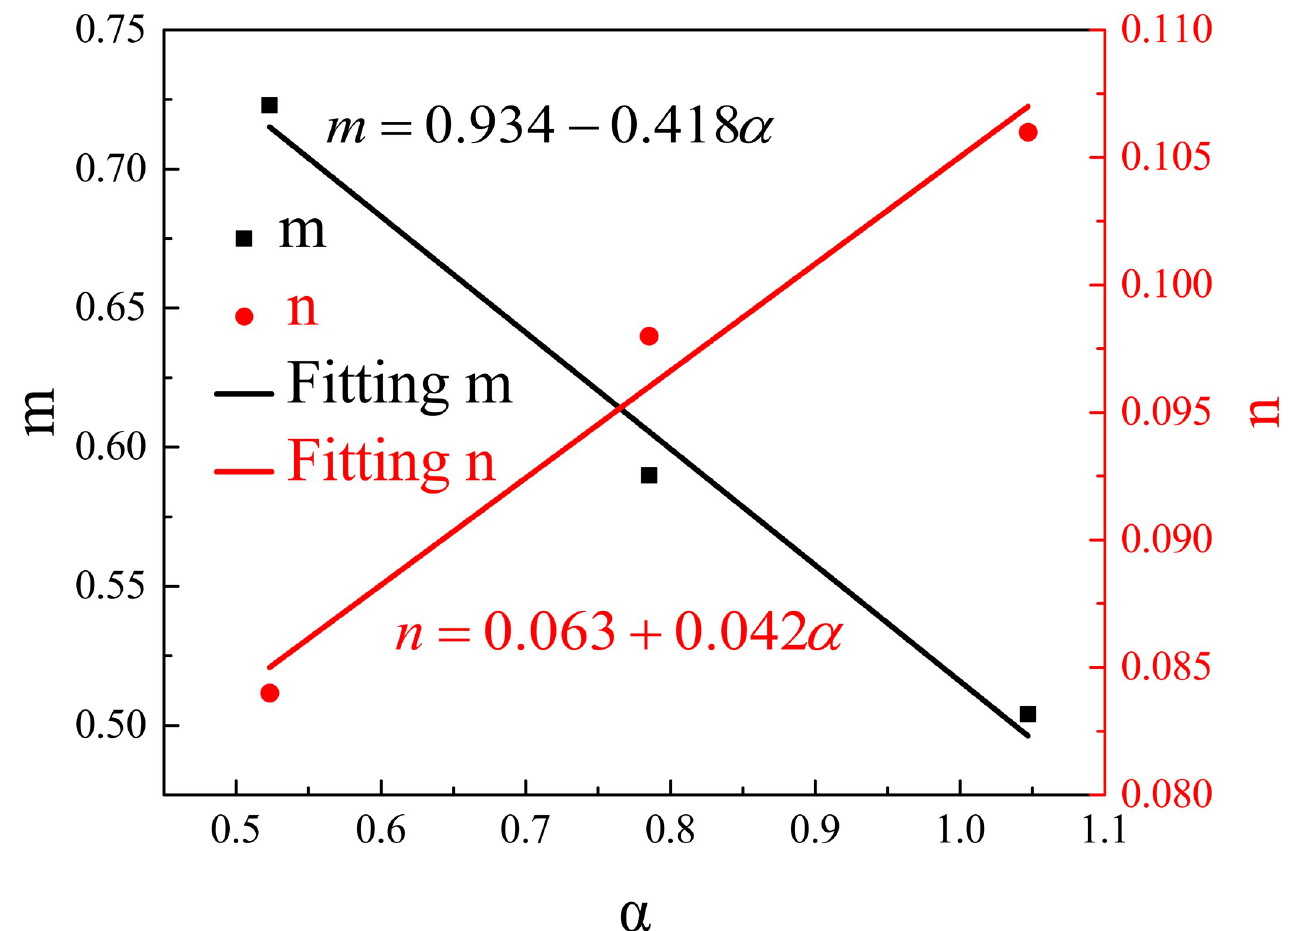
Fig 9. Fitting coefficients of m and n against bifurcation